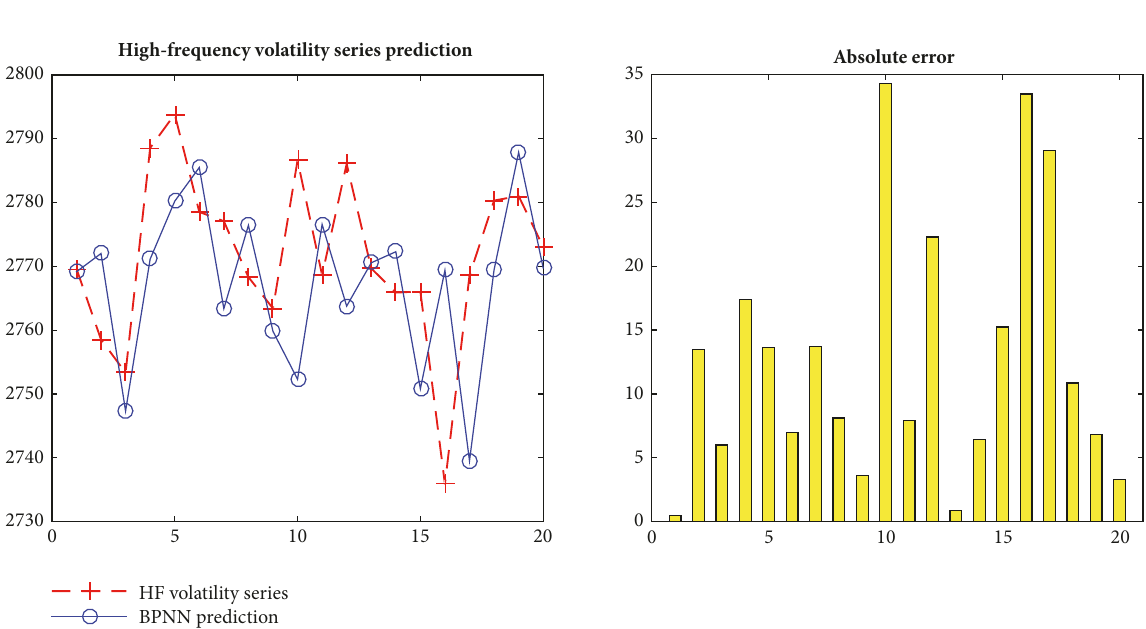
Figure 7: ARIMA prediction results.